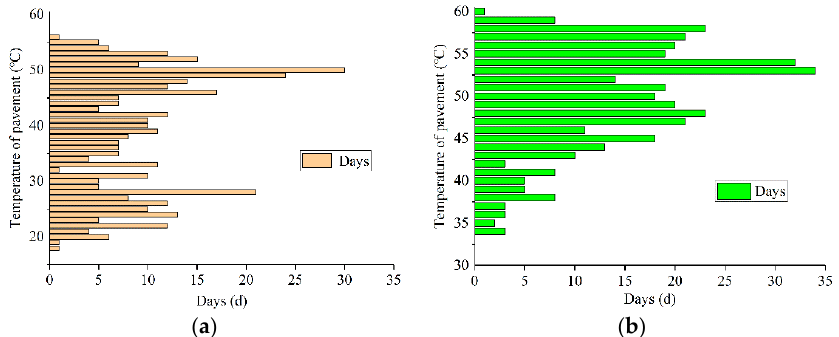
Figure 7. Distribution of daily maximum pavement temperatures in Beijing and Guangzhou in 2006. ( a ) Beijing, ( b ) Guangzhou.